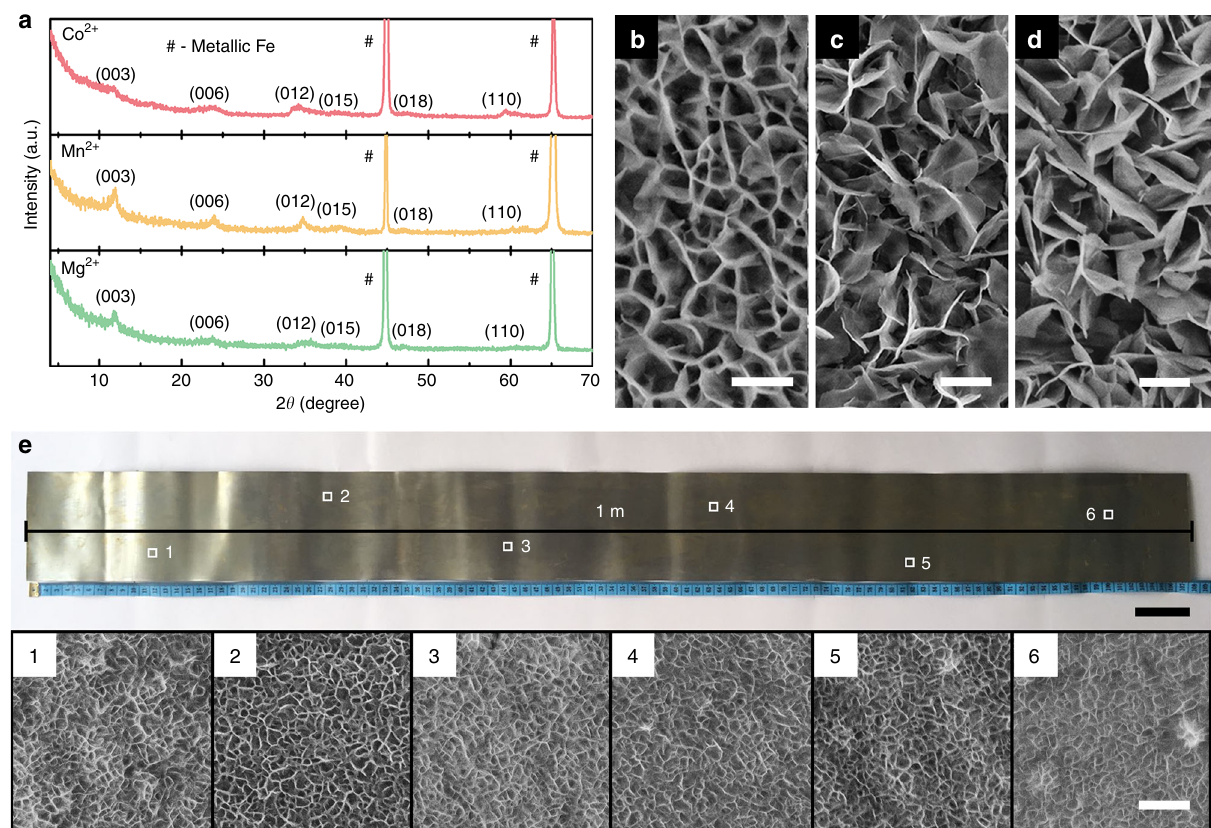
Fig. 3 Extensibility and scale-up experiment of corrosion engineering method a XRD patterns and b – d SEM images of the materials obtained by the corrosive treatment of iron plate in the aqueous solution containing Co 2 + , Mn 2 + , or Mg 2 + cations. Scale bars, 400 nm, 1 μ m, and 1 μ m in b , c , d , respectively. e Digital image of a material (0.1 m × 1 m) obtained from a scaled-up corrosion engineering method in the aqueous solution containing Ni 2 + cations (Scale bar: 5 cm) and the corresponding SEM images of the representative areas 1 – 6, respectively. Scale bar, 400